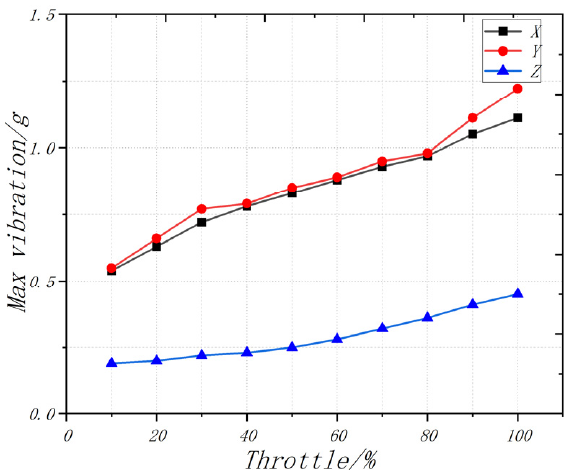
Figure 7. Relationship between throttle volume and maximum vibration peak value.